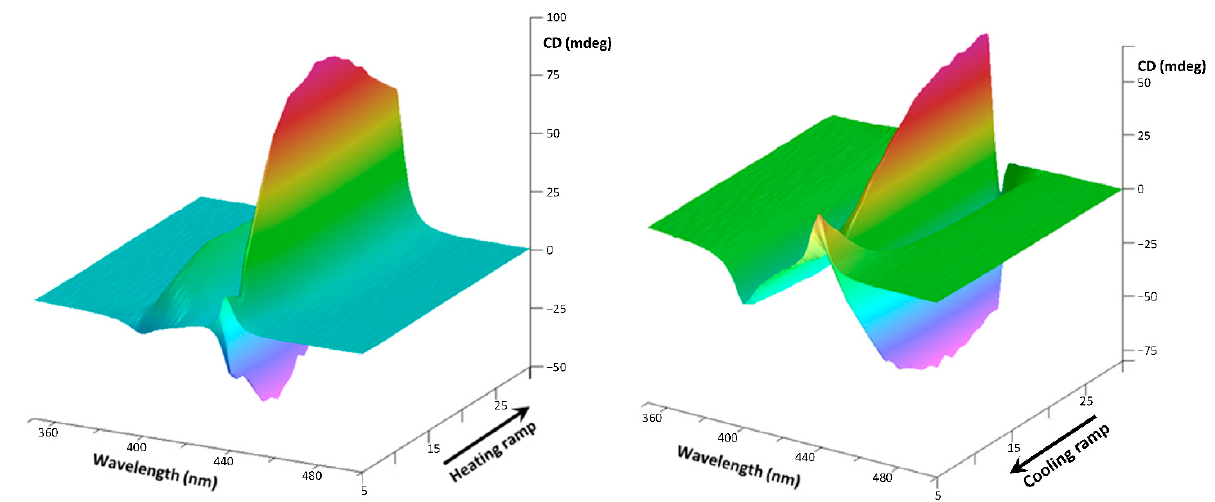
Figure 3. CD spectra collected during heating (from 5 °C to 30 °C, left ) and cooling (from 30 °C to 5 °C, right ) ramps of the StarP water stagnant solution (6 µM).